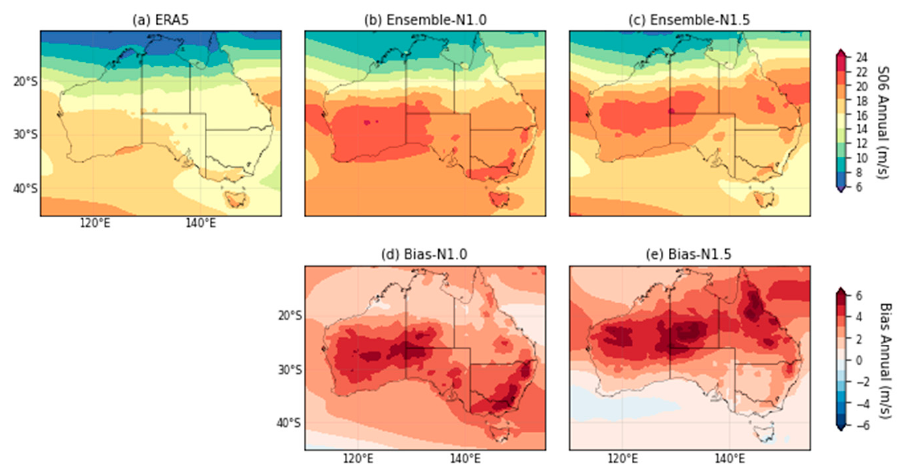
Figure 4. Climatology of the annual S06 in d01 from ( a ) ERA5, ( b ) N1.0 and ( c ) N1.5. ( d , e ) are the biases of N1.0 and N1.5 from ERA5, respectively. Unit: m s − 1 .